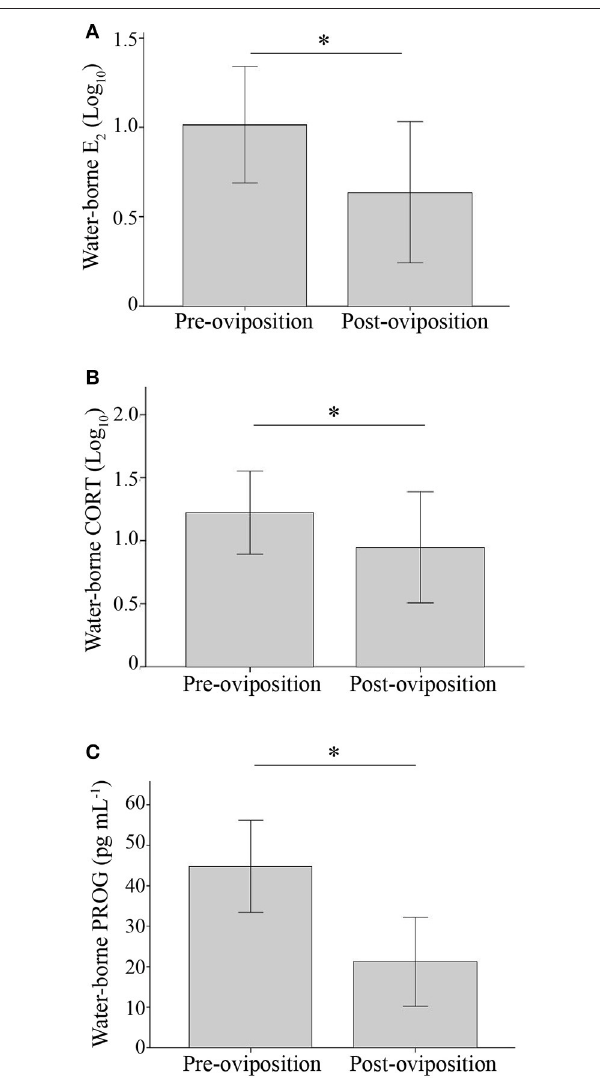
FIGURE 2 | Bar graph illustrating the mean ( ± 1 SD) water-borne hormone concentrations of (A) E 2 (B) CORT (C) PROG before and after oviposition. * p < 0.05.